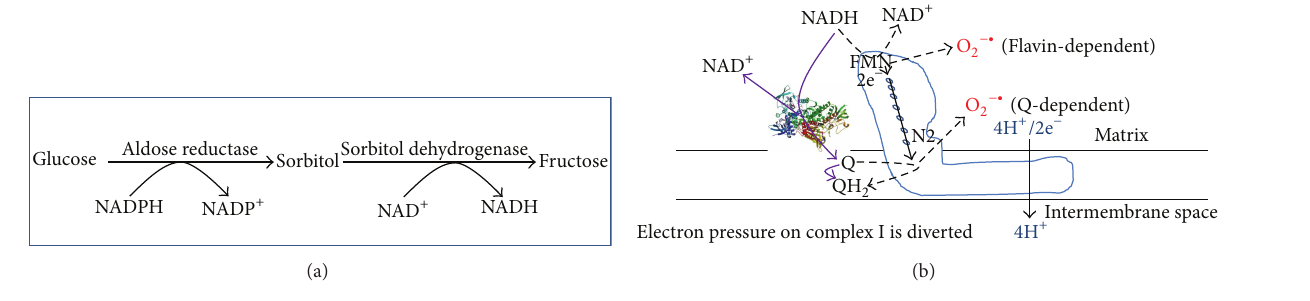
Figure 7: (a) The polyol pathway becomes a major pathway for NADH production under diabetic conditions. NADH is produced in the second reaction catalyzed by sorbitol dehydrogenase. (b) Proposed approach that may alleviate complex I NADH pressure and minimize superoxide production. This could be achieved by a molecule (a protein or a chemical) that can transport electrons from NADH directly to CoQ by bypassing complex I. As this bypass electron transport occurs without proton pumping, no superoxide should be produced, thereby facilitating NADH oxidation and minimizing superoxide